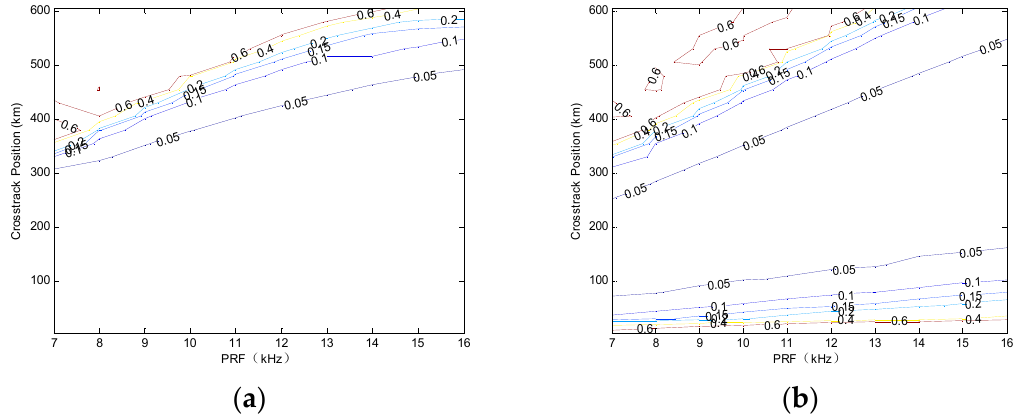
Table 8. Main parameters of the Ka-band DopScat.